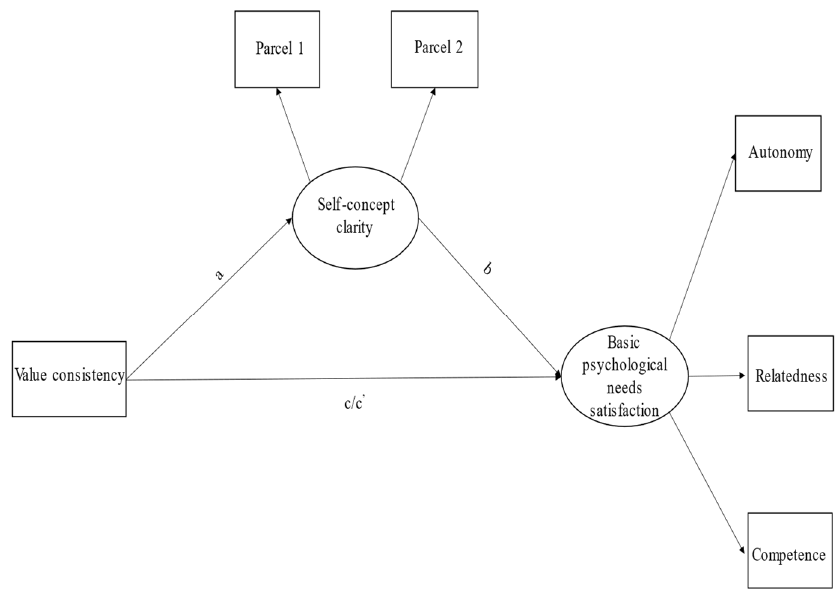
Figure 1. Conceptual mediation model. Note: a was the association of value consistency on self- concept clarity; b was the association of self-concept clarity on basic psychological needs satisfaction; c represents the total effect; c’ represents the direct effect.